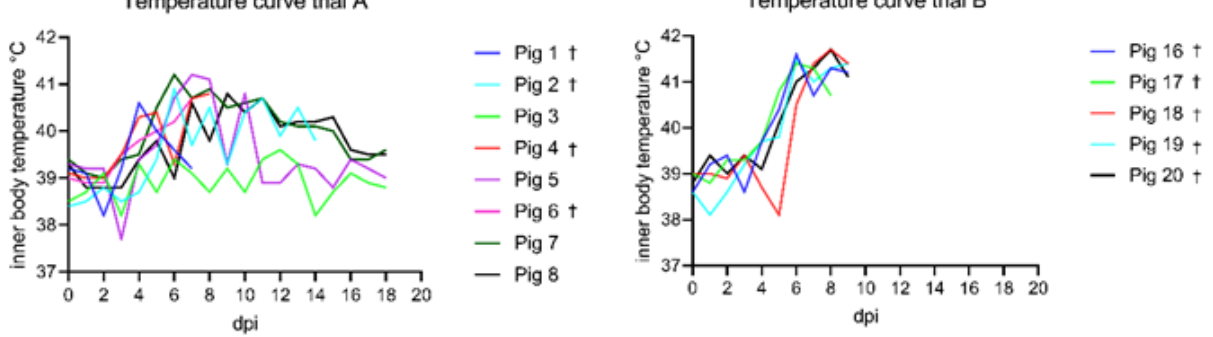
Figure 2. Temperature curves of trials A and B compared. In general, subadult animals of trial A showed lower temperatures compared to the weaner group of Trial B. The maximum temperature recorded in trial A was 41.2 ◦ C at 7 dpi. In trial B, the highest temperature was 41.7 ◦ C at 8 dpi. Animals that showed an acute lethal disease course and reached the humane end point (or died) are marked with a cross.